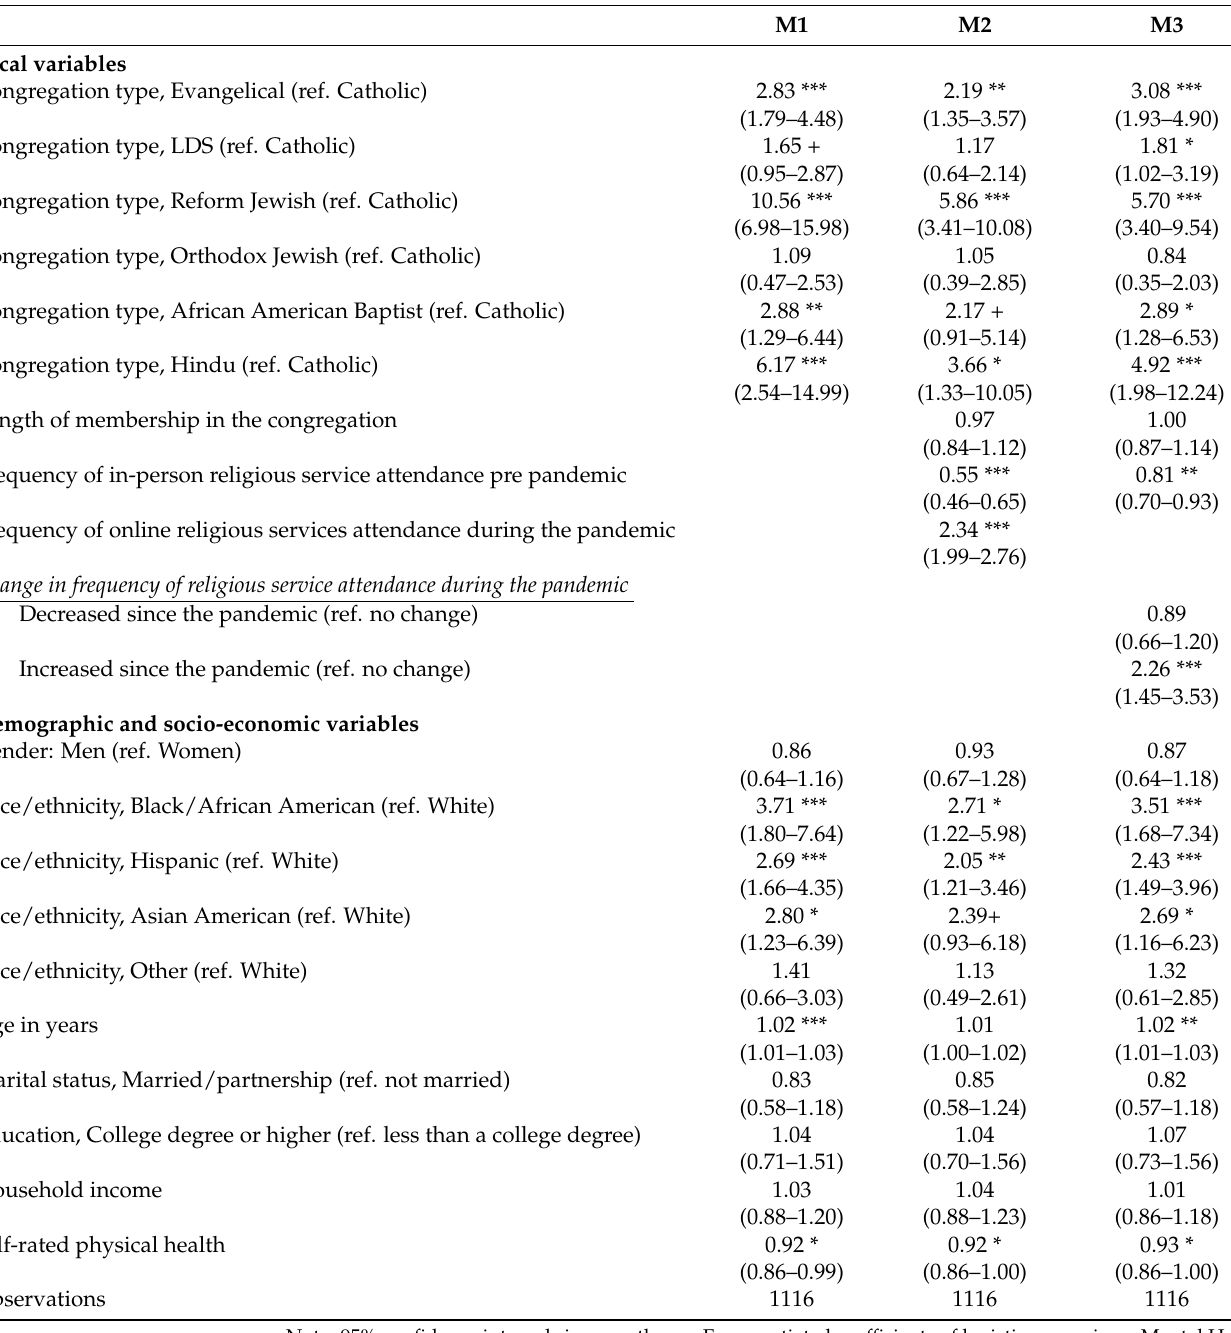
Table 3. Logistic regression results of expectations of attending a mix of online and in-person religious services (vs. in-person religious services only) after the COVID-19 pandemic (n =